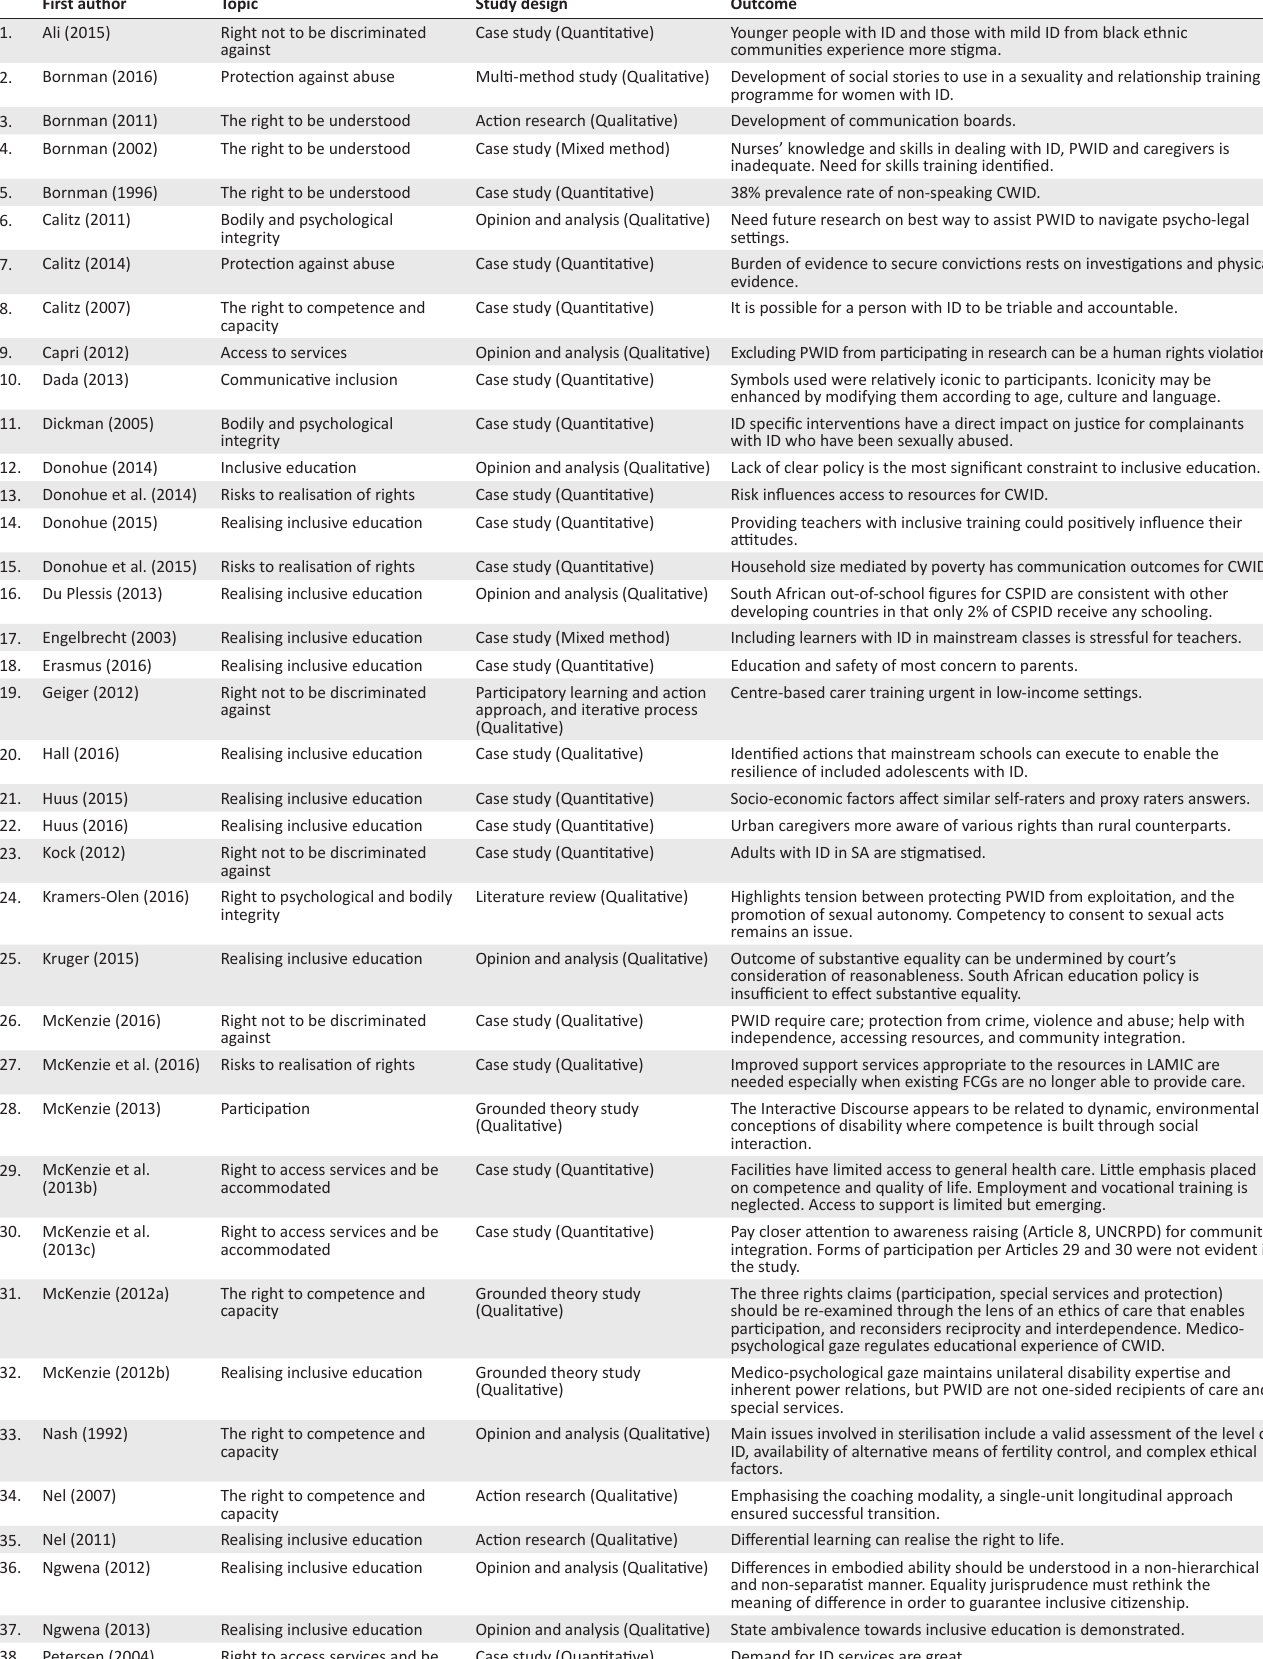
TABLE 4: Characteristics of included studies ( n =